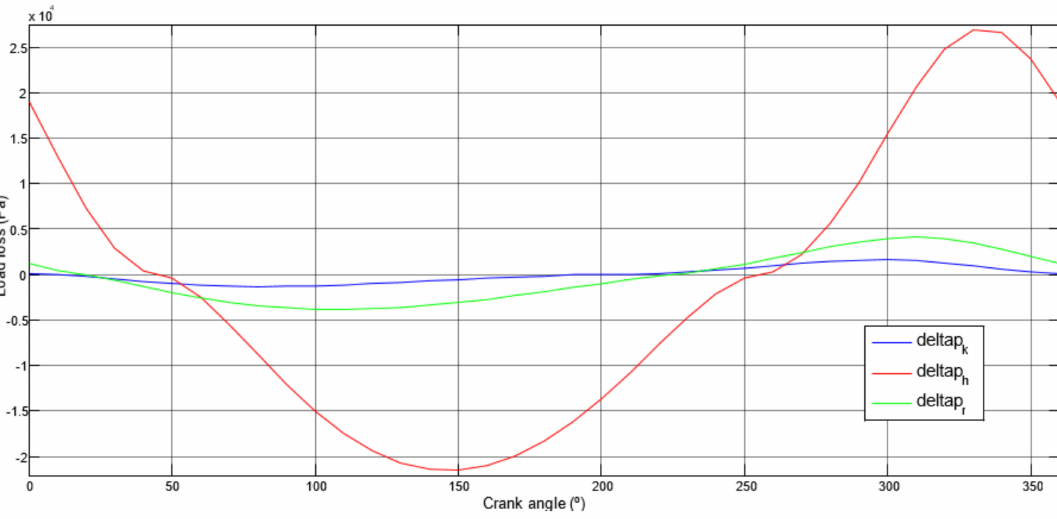
Figure 18. Load losses of the exchangers in the simple